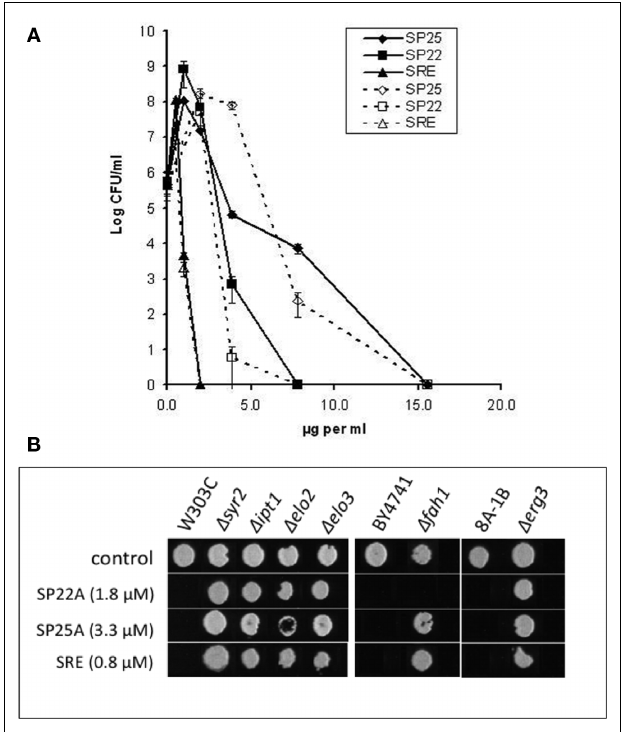
FIGURE 1 | Inhibition of yeasts and lipid mutants by syringopeptins and SRE. (A) Effects of SP25A ( (cid:2) ), SP22A ( (cid:3) ), and SRE ( (cid:4) ) at the designated concentrations on the viability of C. albicans (solid line) and S. cerevisiae strain KZ-1C (dashed lines). Error bars indicate SDs from average values from three separate experiments. (B) Effects on sphingolipid and ergosterol biosynthesis mutants and isogenic parental strains replica